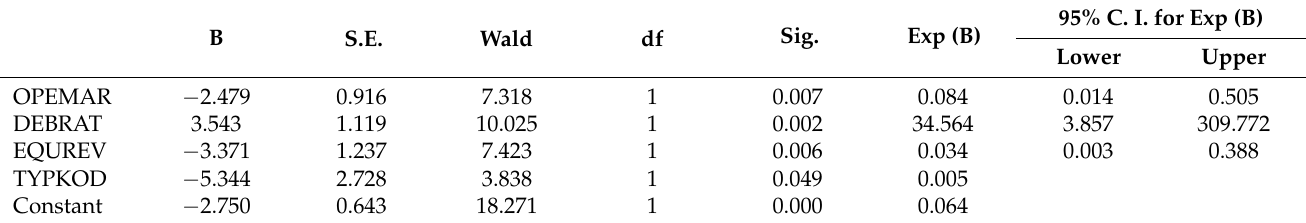
Table 7. Variables in the